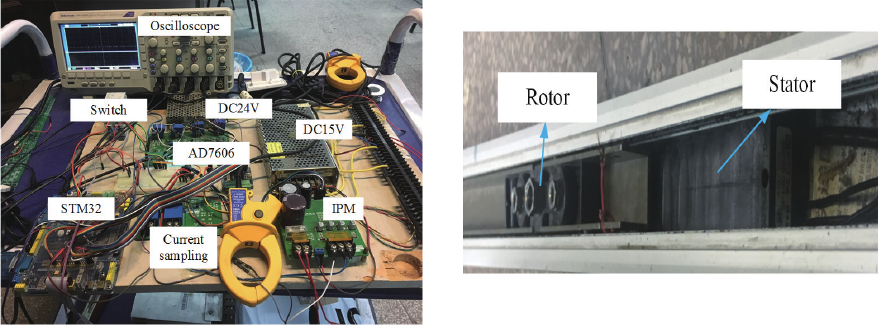
Figure 5. Experiment